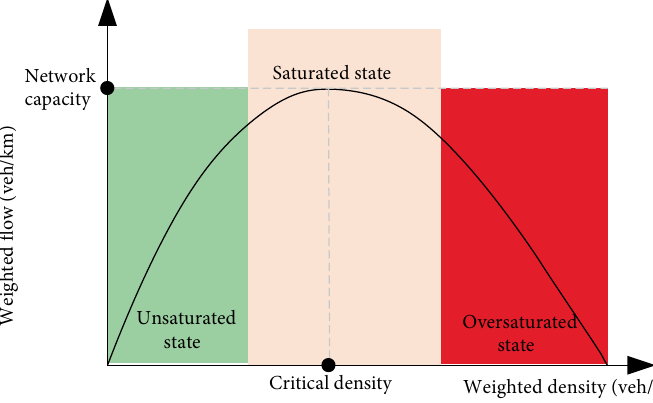
Figure 1: General shape of an